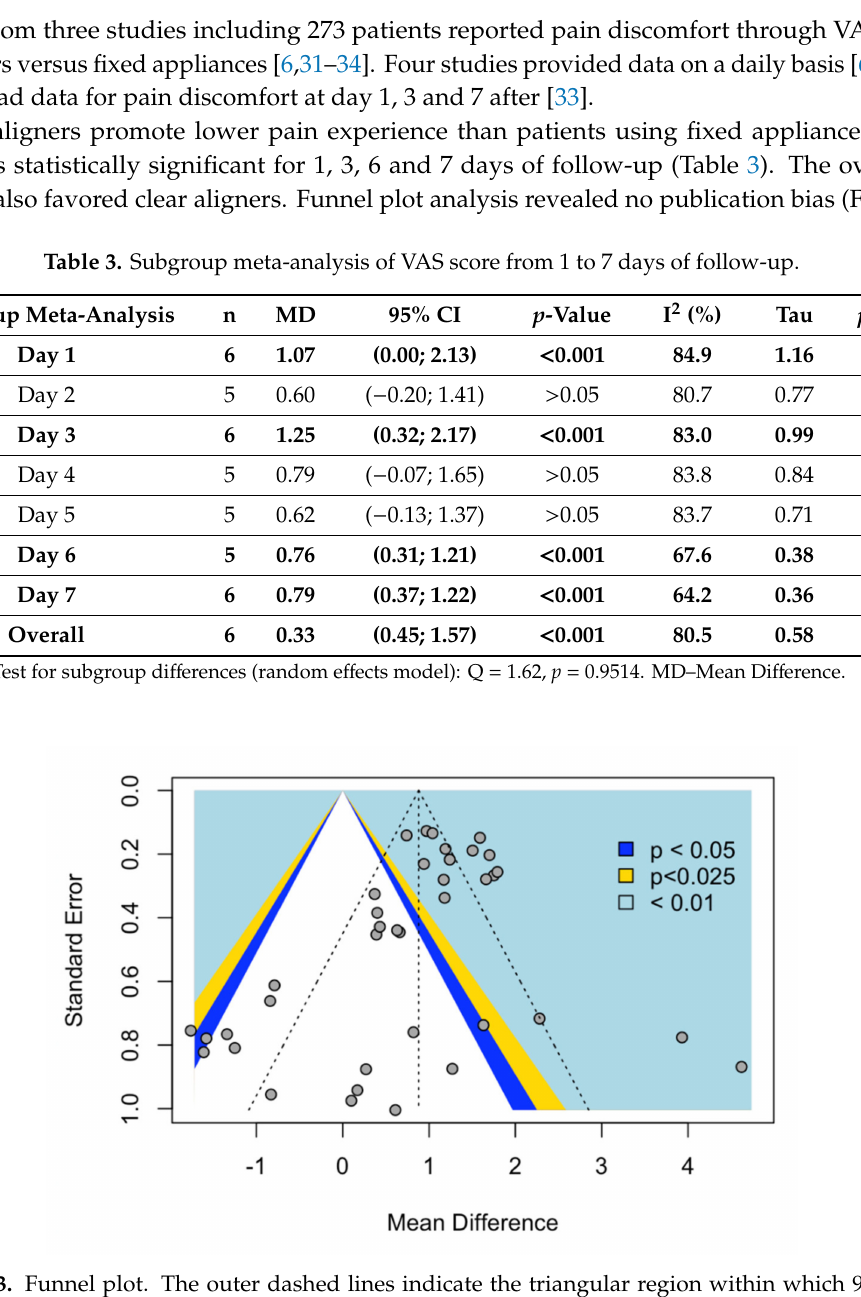
Figure 3. Funnel plot. The outer dashed lines indicate the triangular region within which 95% of studies are expected to lie in the absence of both biases and heterogeneity (fixed e ff ect summary log odds ratio ± 1.96 × standard error of summary log odds ratio). The dashed vertical line corresponds to no intervention e ff ect. The distribution gives a clear visual impression of symmetry, which is confirmed by a p >